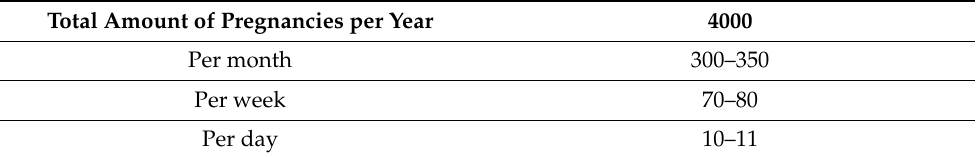
Table 1. Number of delivered pregnancies in the selected study